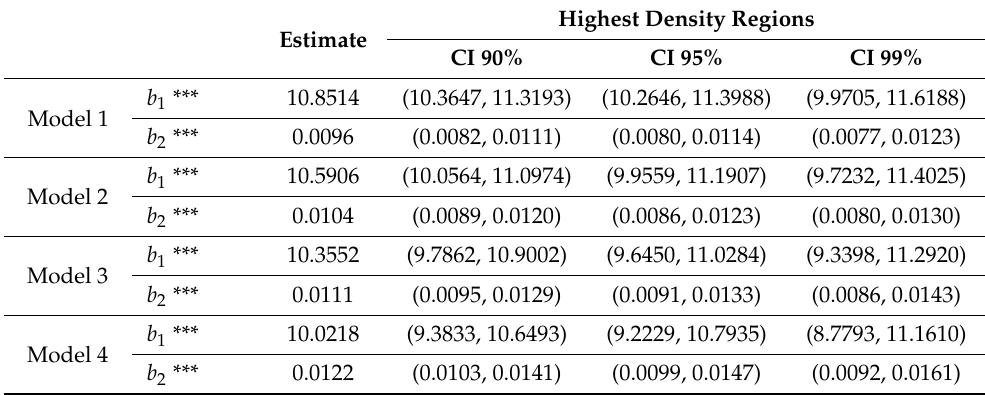
Table 2. Results for Model 1 to Model 4 (data from 1959 to 1989).